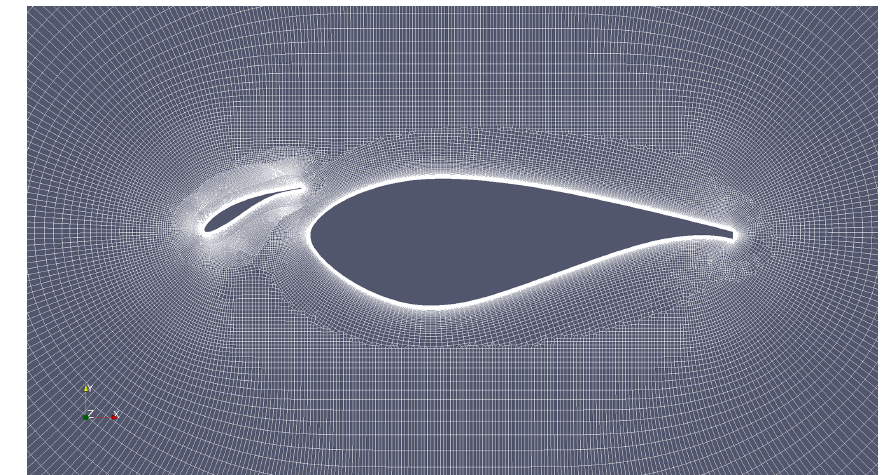
Figure 2. Benchmark configuration with DU97-W-300 base airfoil and a NACA-22 slat element.